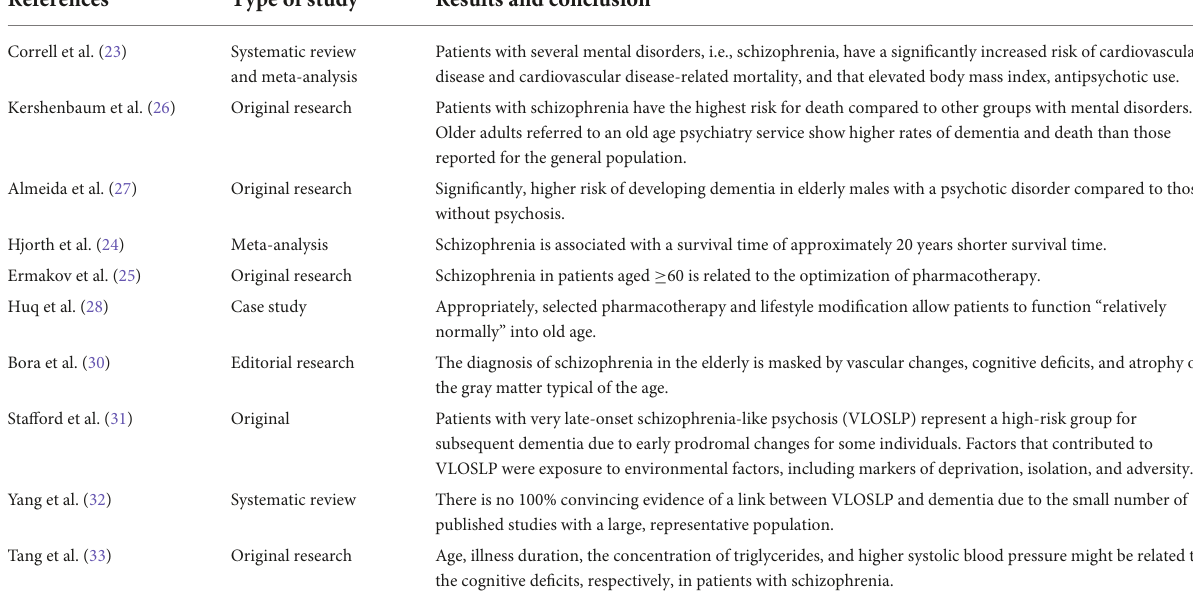
TABLE 2 Studies on schizophrenia and the risk of developing other